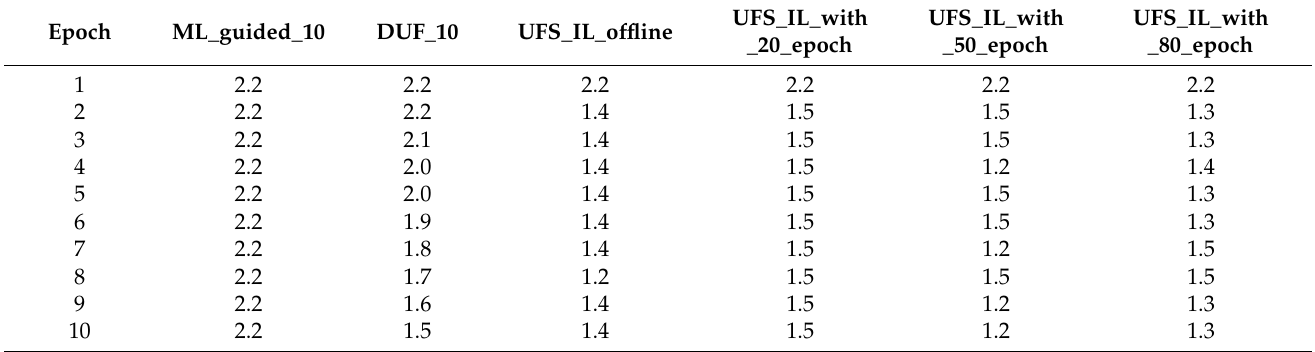
Table A1. Uncore frequency selections for different policies under the MG app throughout the control period. The unit of frequency is